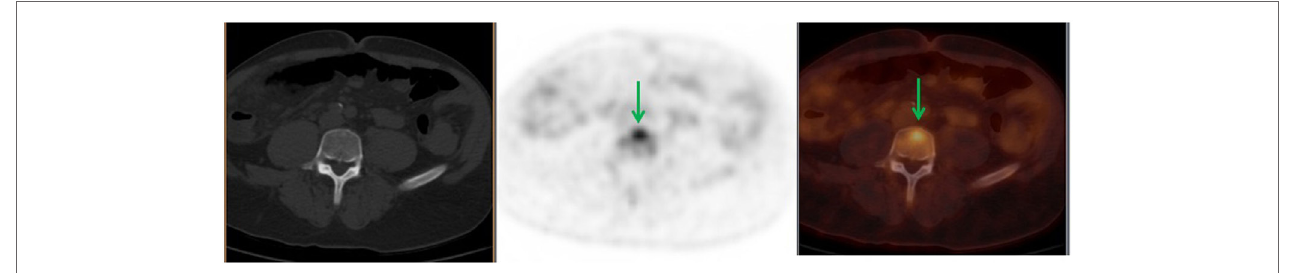
FigUre 2 | a 56-year-old male diagnosed with stage iiic adenocarcinoma of the ascending colon status post right hemicolectomy . Follow-up, 18F-FDG PET demonstrated L5 FDG-avid lesion (green arrows) with no corresponding bone changes in the CT. This finding upstaged his cancer to stage IV. Patient received XRT and offered hospice.